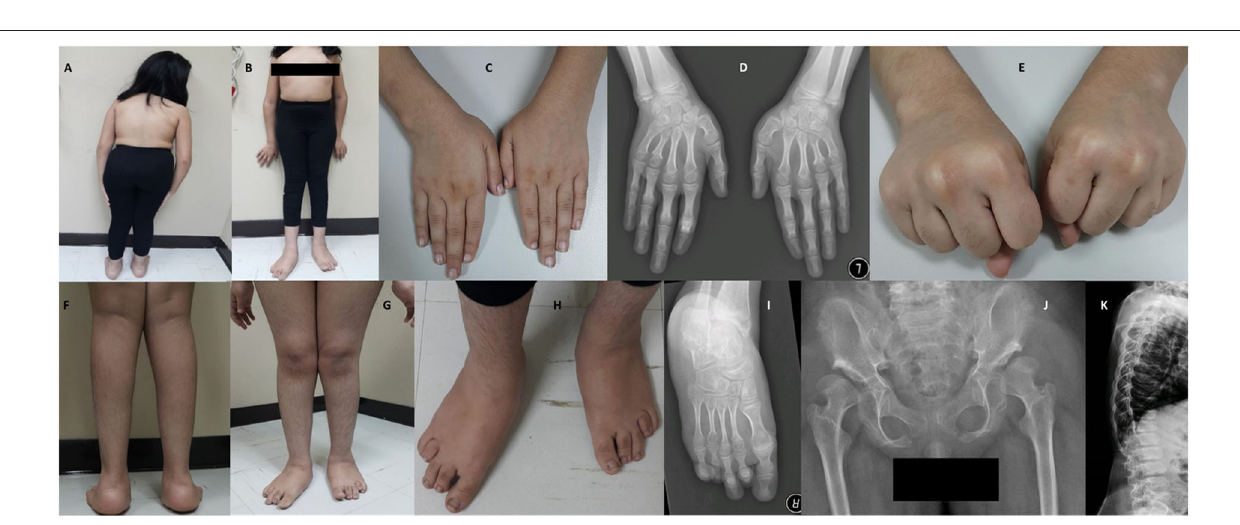
FIGURE 2 | Photos and X-rays of Case-I (IV-7) are showing short trunk, coxavara, mild genu valgum (A,B) short first, fourth and fifth fingers and metacarpals (C,D) and absent fourth and fifth knuckles during fist formation (E) , prominent heels, pes planus, brachydactyly of toes more prominent 4th and 5th with short metatarsals (F–I) , A-P hips X-rays shows bilateral shallow saucerized acetabulum with abnormally flat and enlarged femoral head and narrow femoral neck, lace-like small iliac wings and bilateral coxa valga (J) . X-rays of spines show double hump appearance with antero-inferior beaking of the vertebral bodies (K)